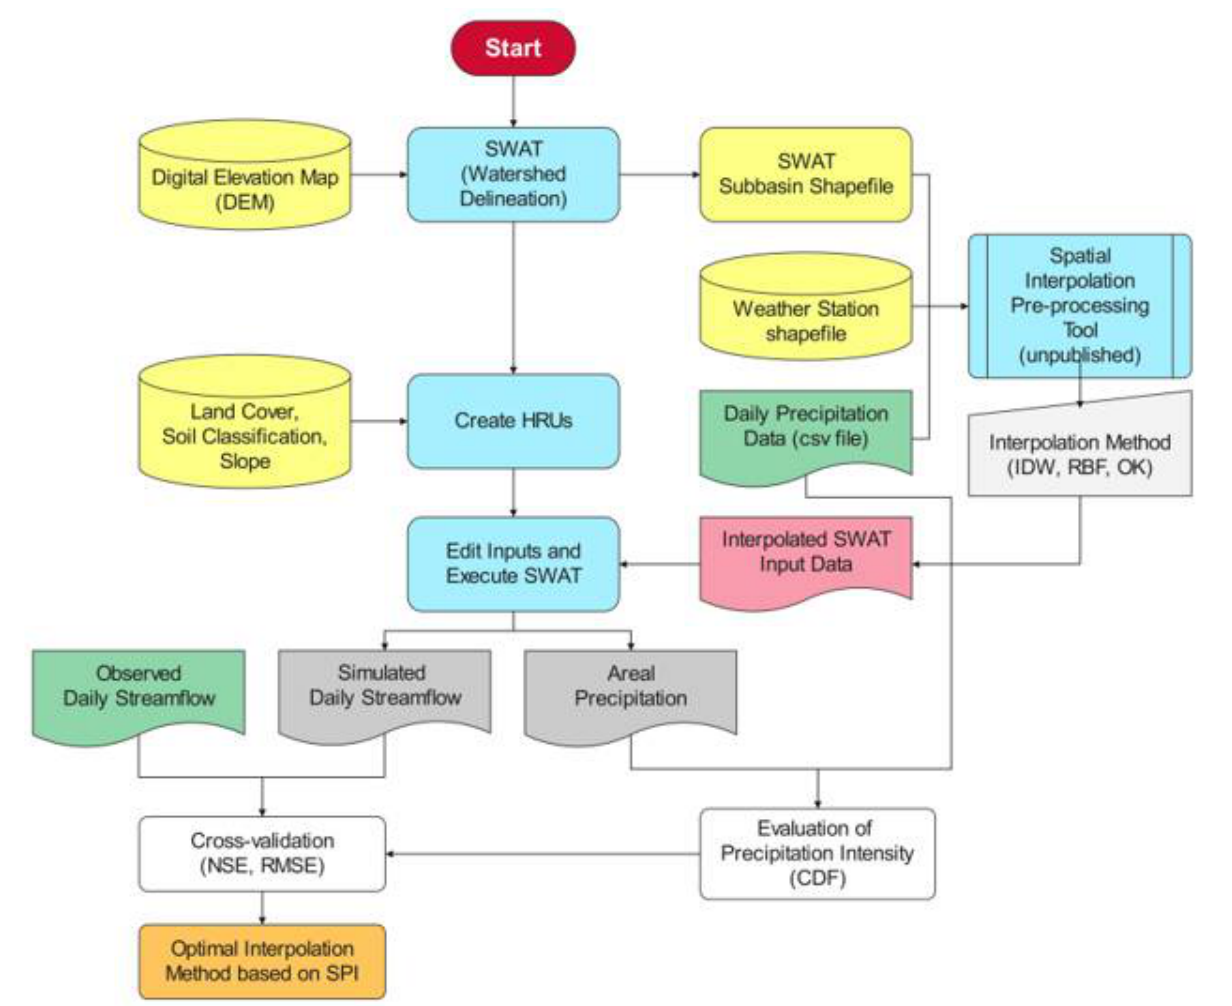
Figure 4. Flowchart of research methodology.